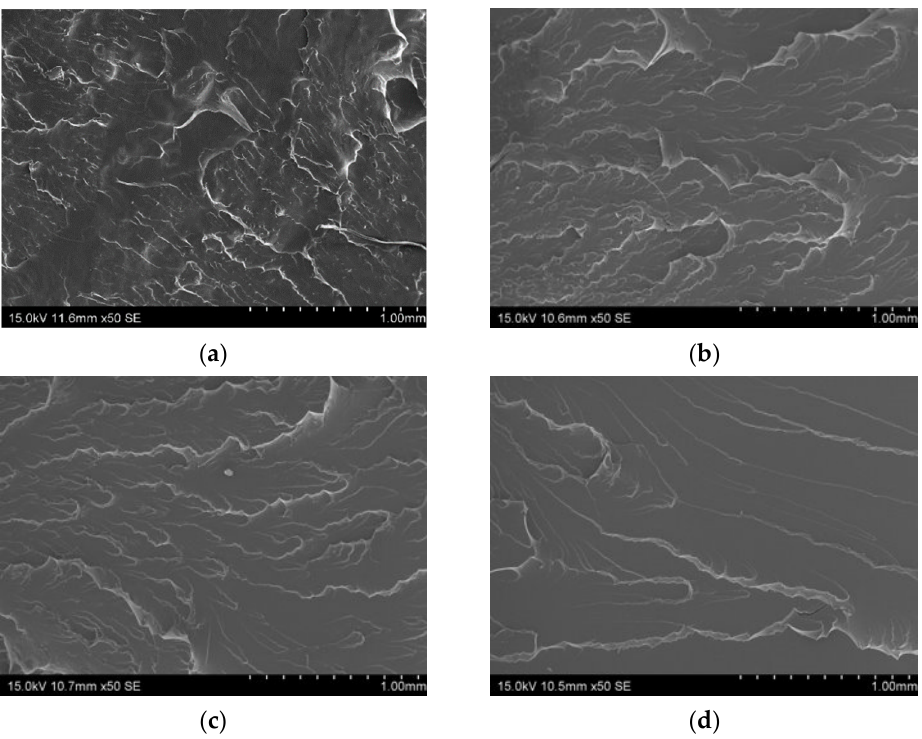
Figure 5. SEM images of fracture surfaces of CNT doped PEGDGE nanocomposites at ( a ) 140 ◦ C for 8 h, ( b ) 160 ◦ C for 4 h, ( c ) 160 ◦ C for 5 h and ( d ) 180 ◦ C for 3 h curing